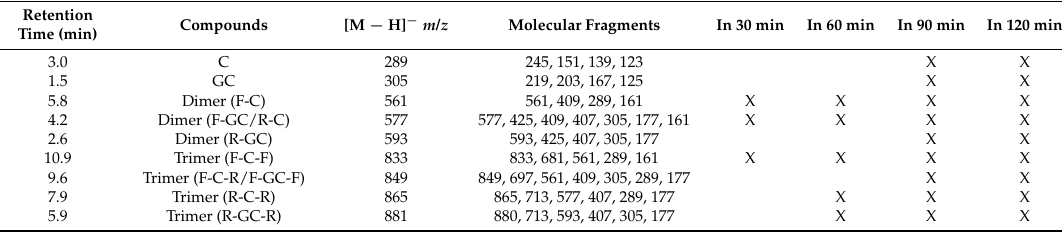
Table 2. Components identified of the IN sample from A. mearnsii bark after simulated gastric- intestinal